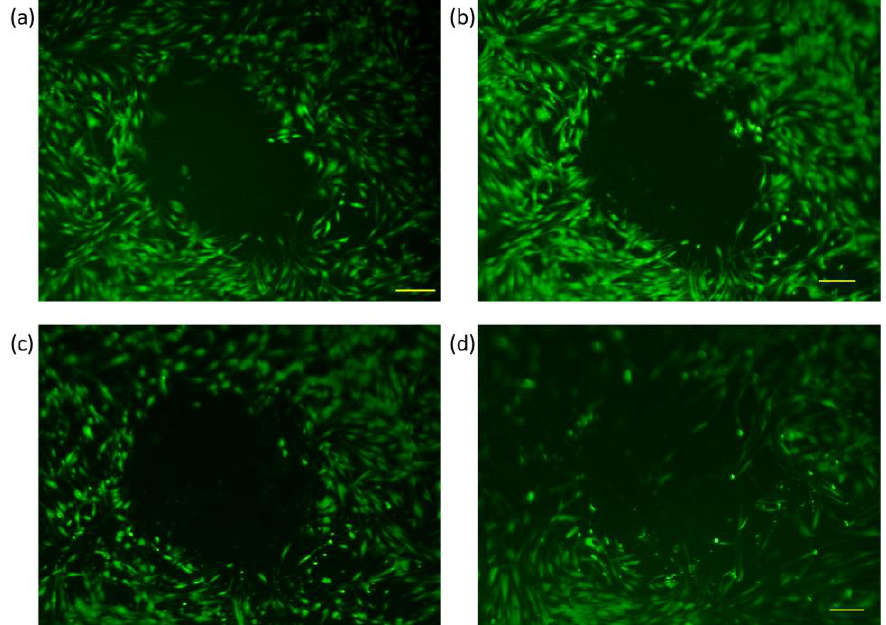
Figure 8. Fluorescence microscopy images of dermal fibroblasts from an 88-year-old donor at four different time frames (Training Group) ( a ) Initial, ( b ) 24 h, ( c ) 48 h, and ( d ) 4 days .